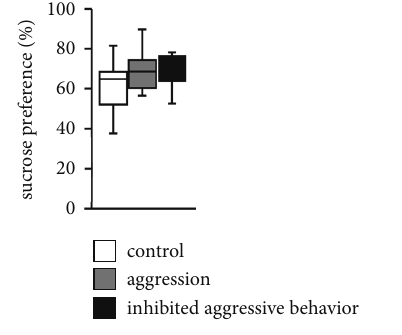
Figure 6: Performance of aggressive behavior-inhibited mice in the sucrose preference test. Percentage of sucrose water consumption at 6hours in the sucrose preference test. The data are presented as box plots. * p < 0 : 05 and + p < 0 : 1 . Control group: n = 7 ; aggression group: n = 7 ; and inhibited aggressive behavior group: n = 7